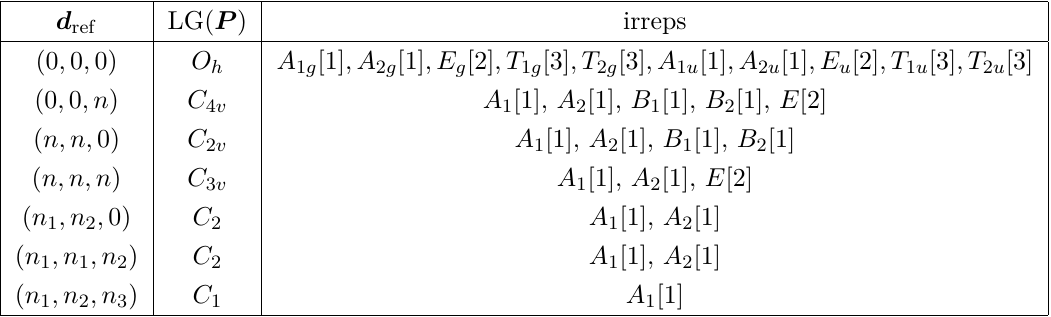
= P L/ (2 π ) , taking a canonical choice for def , n , and n are nonzero, with n , n , and n being 1 2 3 1 2 3